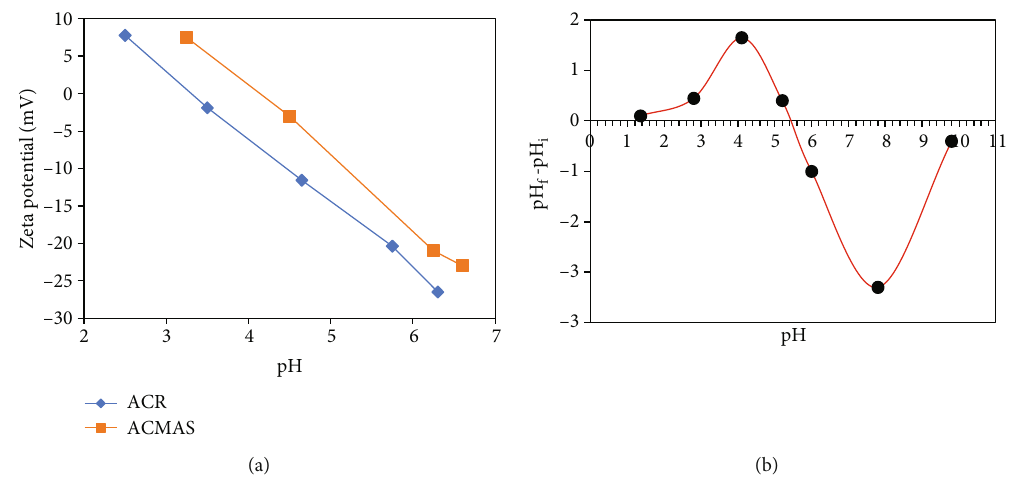
Figure 10: Plot for (a) zeta potential for ACR and ACMAS and (b) point of zero charge for ACMAS.